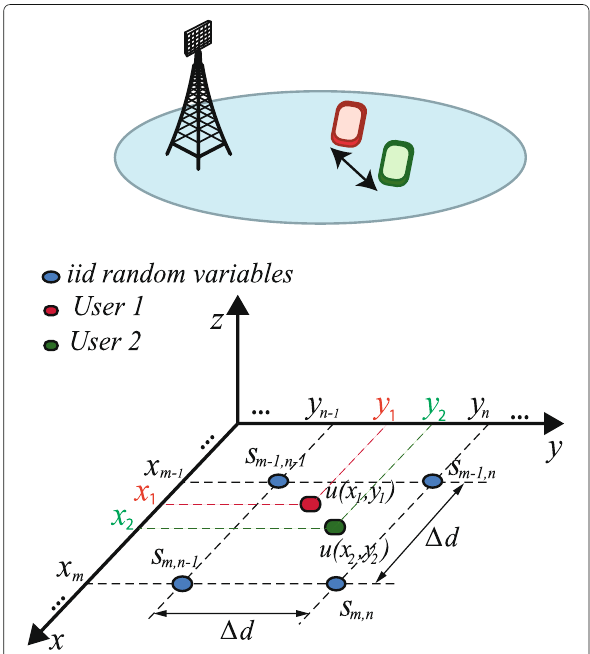
Fig. 6 Spatially correlated SSPs. To generate spatially correlated SSPs, independent and randomly distributed variables are generated only on the grid points, which are denoted by blue dots in the figure. For the user positions within this grid, the corresponding values are determined by using bilinear interpolation